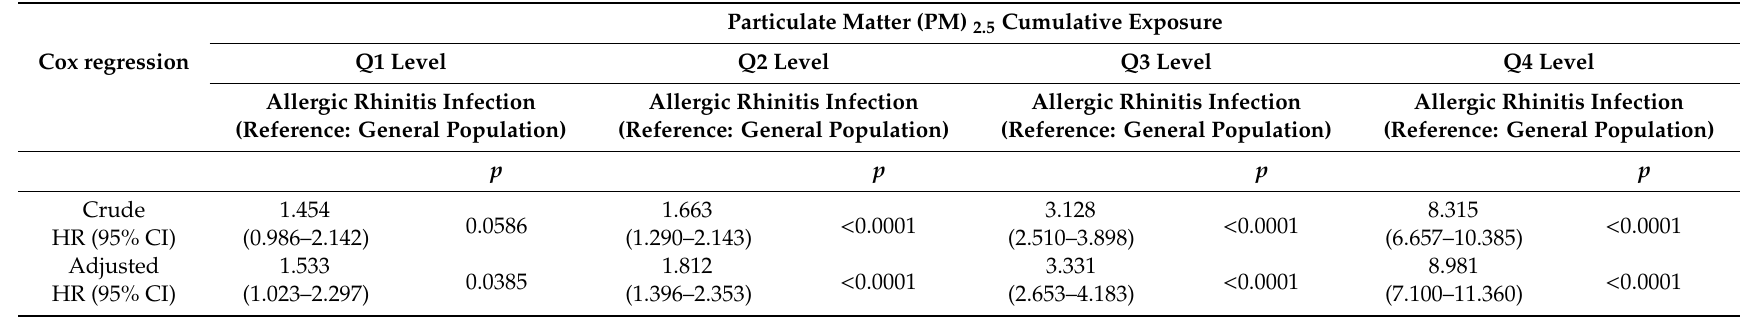
Table 3. The risk of patients with AD with AR versus PM 2.5 exposure level stratified by demographics, crude HR, and adjusted HR in Cox proportional hazard